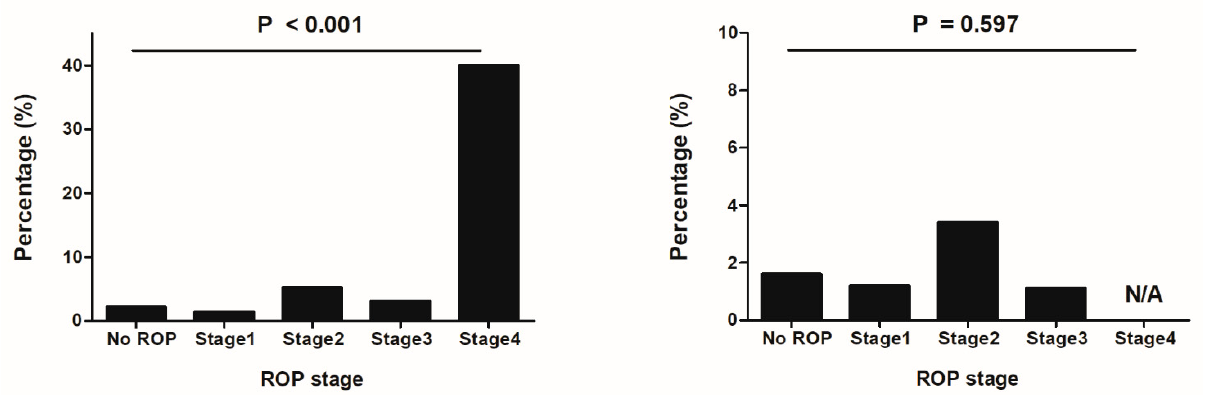
Figure 2. Prevalence of hearing impairment in subgroups of retinopathy of prematurity stages at 18 months ( left ) and 3 years ( right ) of age.